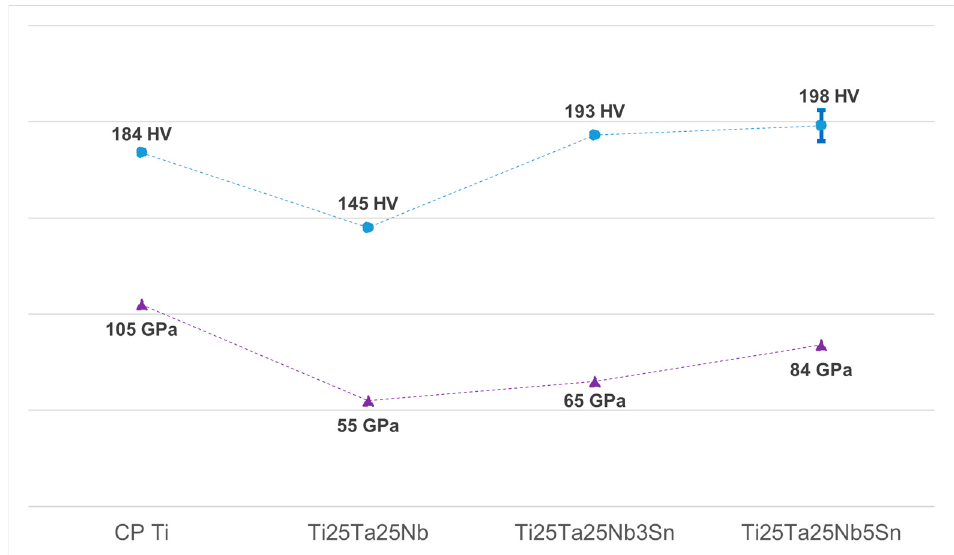
Figure 3. Mechanical properties of Ti-25Ta-25Nb-5Sn alloy compared with CP Ti, Ti-25Ta-25Nb and Ti-25Ta-25Nb-3Sn.